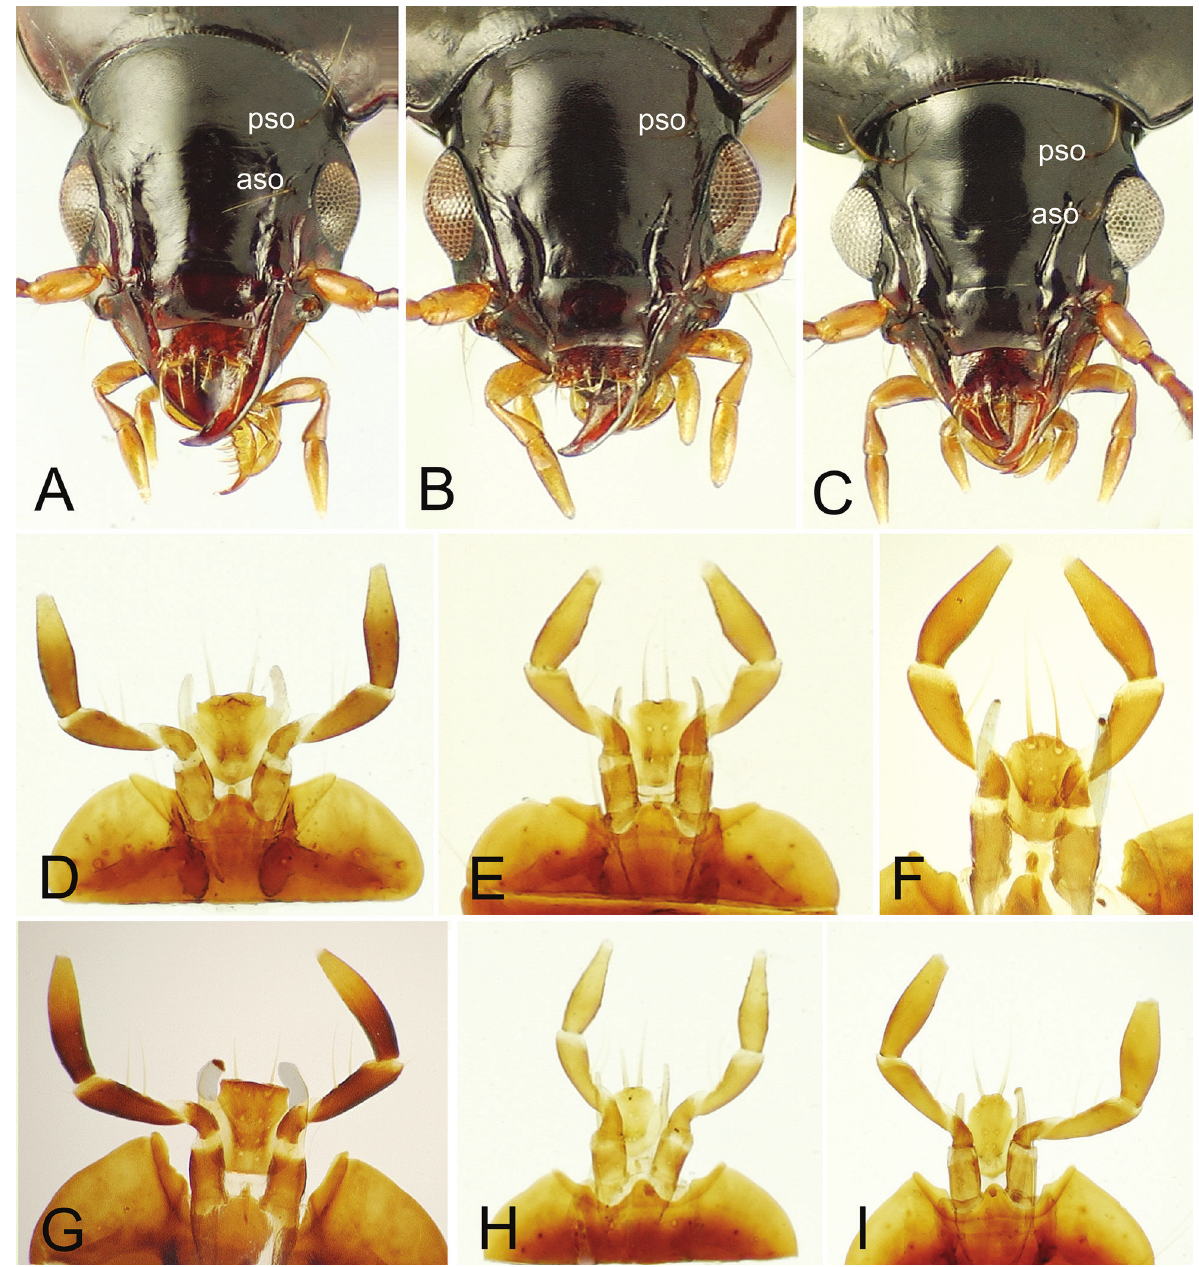
Figure 1. Head and mouthpart structures of Mecyclothorax spp. A–C . Head capsule, dorsal view: A , M. goweri ; B , M. fleutiauxi ; C , M. laterorectus . D–I , Mentum, labial palps and ligula: D , M. peryphoides , ventral view; E , M. storeyi , ventral view; F , M. ampli- pennis , dorsal view; G , M. montivagus , dorsal view; H , M. kanak , ventral view; I , M. fleutiauxi , ventral view. Abbreviations include: aso , anterior supraorbital seta; pso , posterior supraorbital